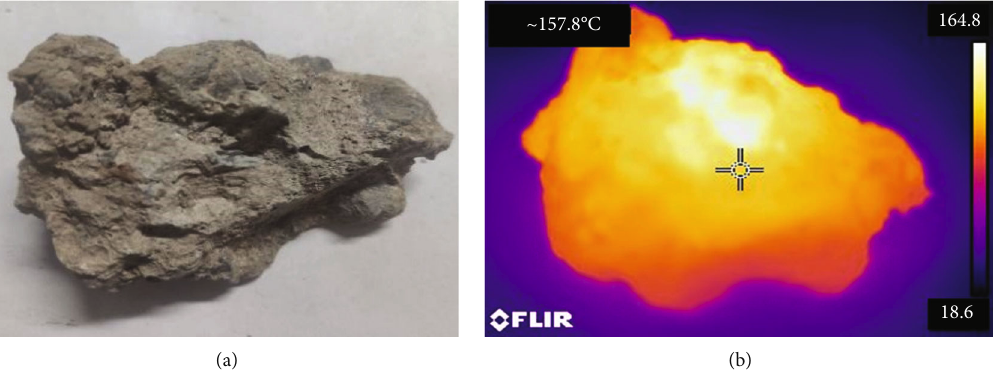
Figure 1: Temperature distribution diagram after 8 min of microwave irradiation at 800 W: (a) concrete block; (b) temperature